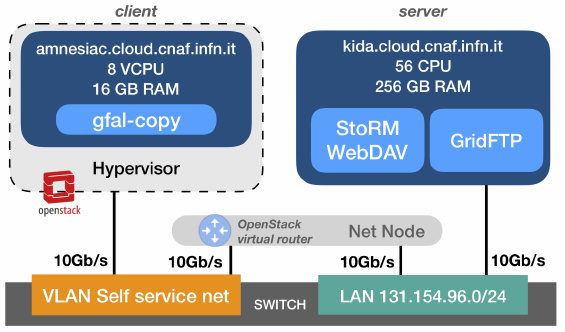
Figure 3. The GridFTP vs WebDAV